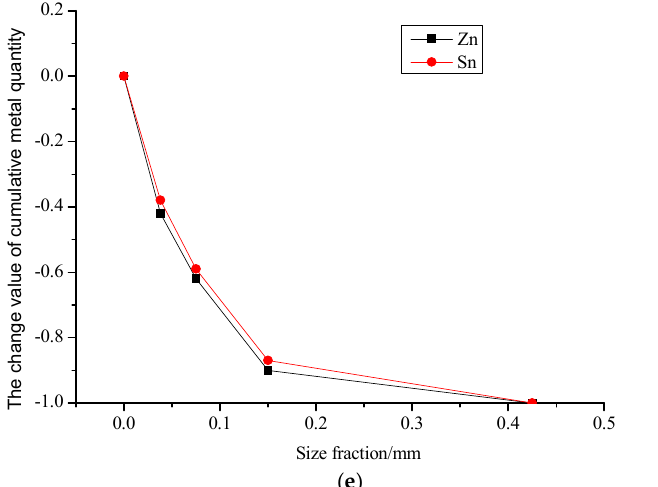
Figure 3. Changes in the cumulative quantities of metal for Zn and Sn with various size fractions and grinding times. ( a ) Grinding time is 2 min. ( b ) Grinding time is 4 min. ( c ) Grinding time is 6 min. ( d ) Grinding time is 8 min. ( e ) Grinding time is 10 min. Table 5. Changes in the value of cumulative metal quantity for different grinding times. Grinding Time is 2 Particle Size/mm Particle